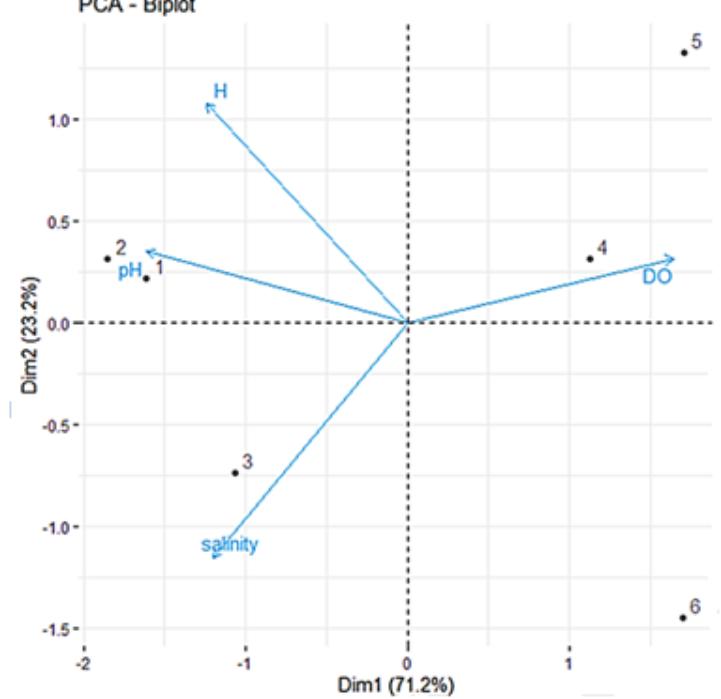
Fig. 9: PCA plot showing intact (1, 2, 3) and disturbed (4, 5, 6) sites related to H’, DO, salinity, and pH